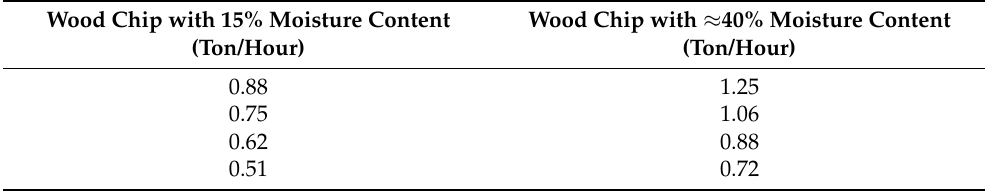
Table 4. Calculated mass feed rate of raw wood chips from required dried wood